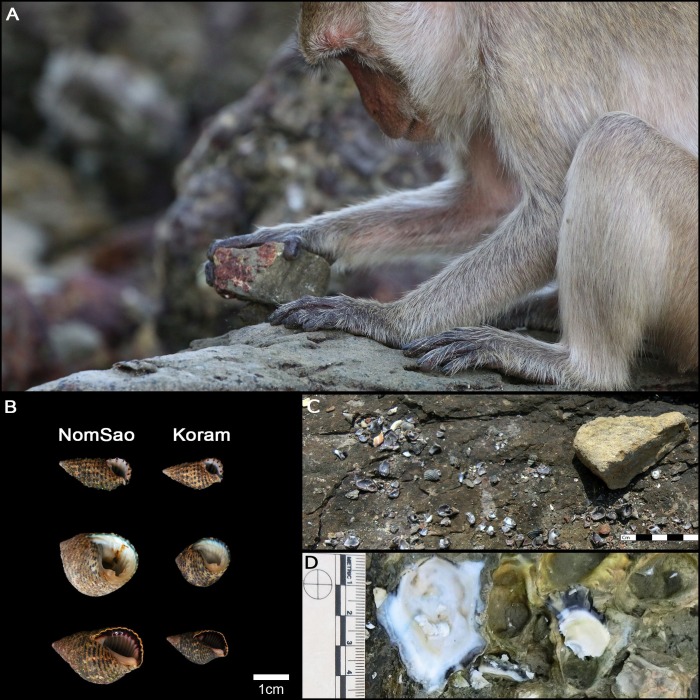
Long-tailed macaque tool use.(A) Adult male long-tailed macaque using a stone tool to crack open a snail. (B) Size difference between NomSao and Koram Islands of most commonly harvested snails. (C) Abandoned macaque tool at shellfish cracking site, with prey remains. (D) Recently harvested oysters (white) are clearly distinguishable from older oysters (grey).